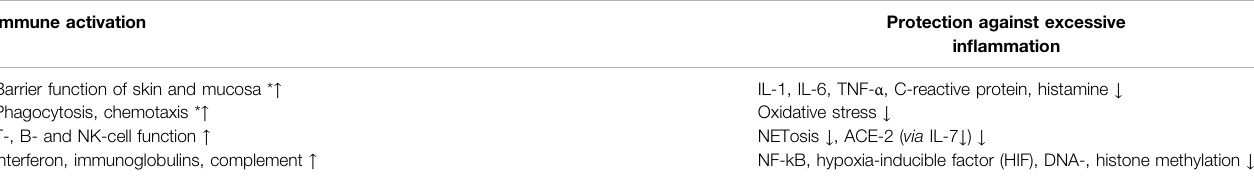
TABLE 1 | Immune modulating functions of vitamin C based on (Institute Of Medicine Panel On Dietary Antioxidants And Related Compounds, 2000; Carr and Maggini, 2017;Angetal.,2018;LeeChongetal.,2019;Mousavietal.,2019).*importantforsynthesisand/orfunction, ↑ increasedactivityorsynthesisondemand, ↓ reductionin pathological elevated